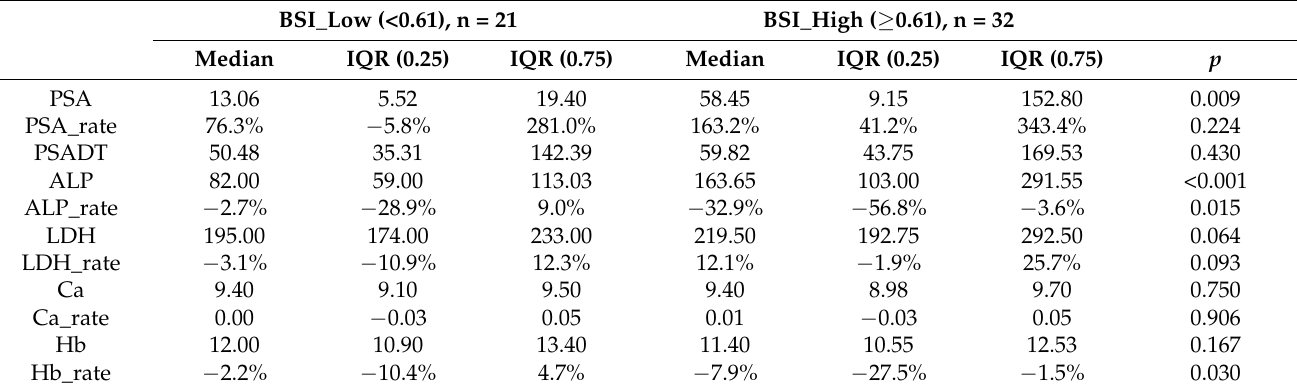
Figure 1. The ROC curve of baseline bone scan index. The Youden index and the left upper angle nearest point of the ROC curve were both 0.61, which was determined as the cutoff point of BSI. AUC: area under the ROC; ROC: receiving operator characteristic curve. Table 3. Comparison between 2 groups (BSI_low vs. BSI_high) (MWU